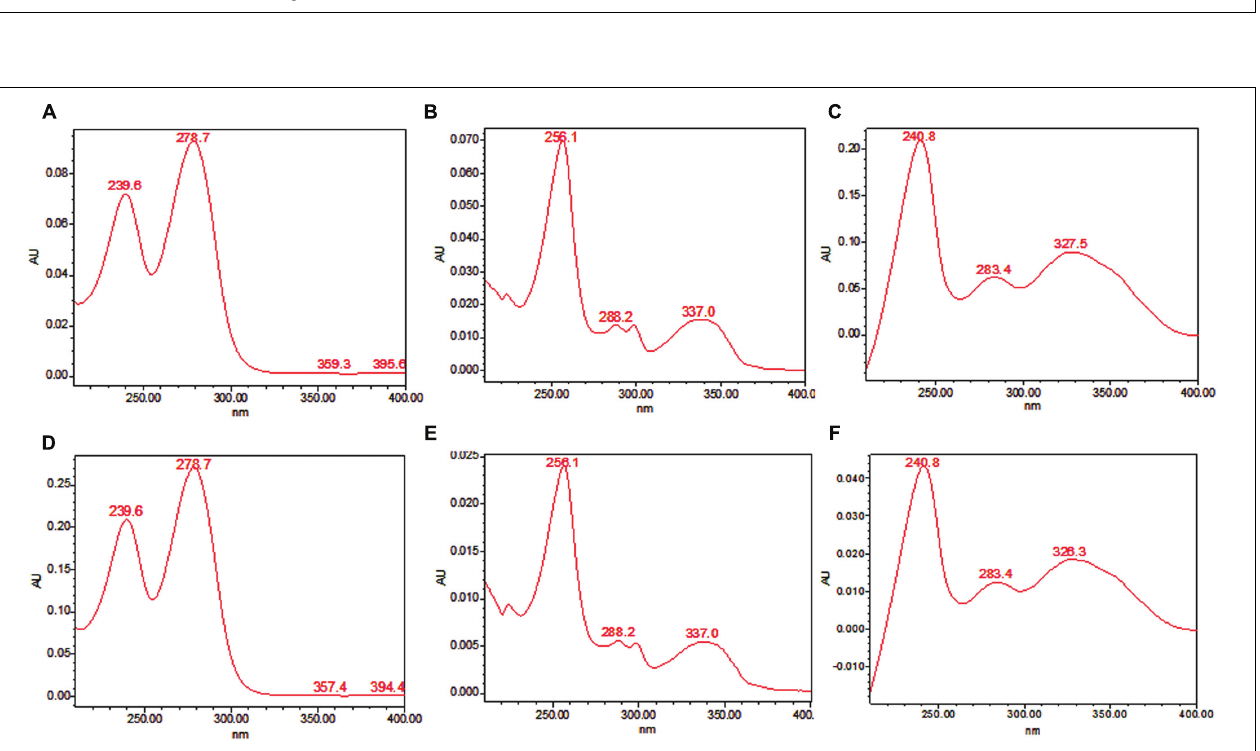
FIGURE 2 | (A) Isolation, purification, characterization, and infection of pathogen A. alternata on tomato plant. (B) Infection on detached leaves of tomato plant by the A. alternata and its toxins, showing the area of necrotic lesions and control leaves without necrotic lesions.